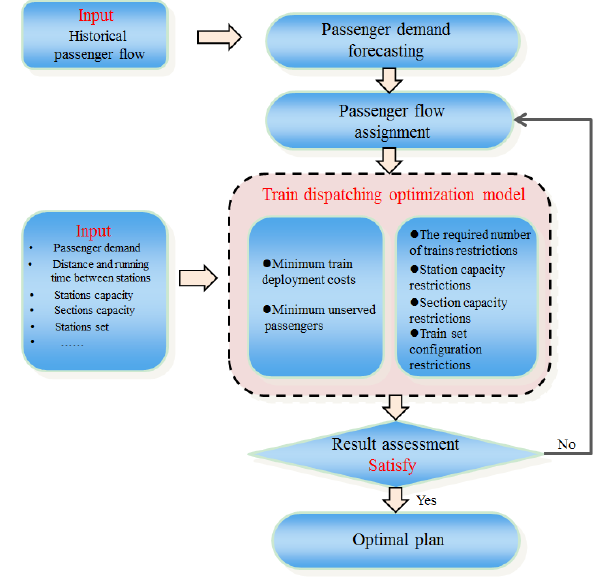
Figure 1. The structure of a train dispatching model based on fuzzy passenger demand forecasting